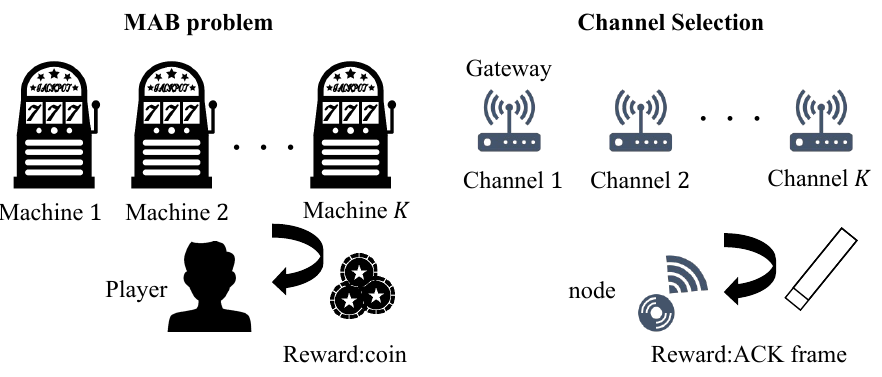
Figure 4. MAB problem vs. channel selection problem.